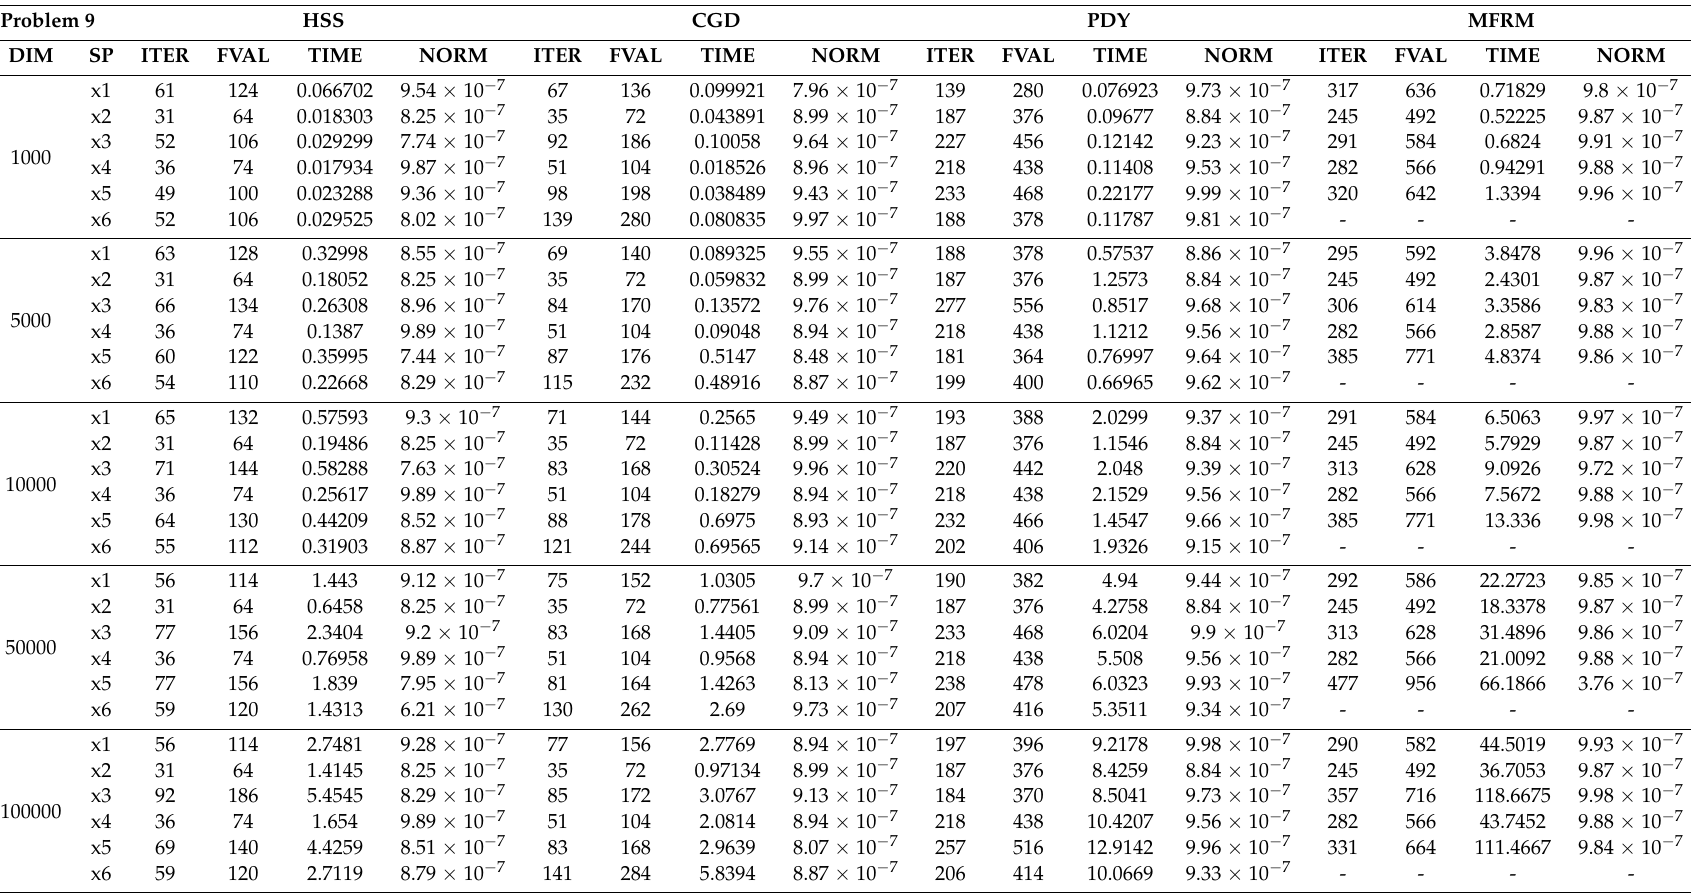
Table 9. Test results obtained by the four solvers for Problem